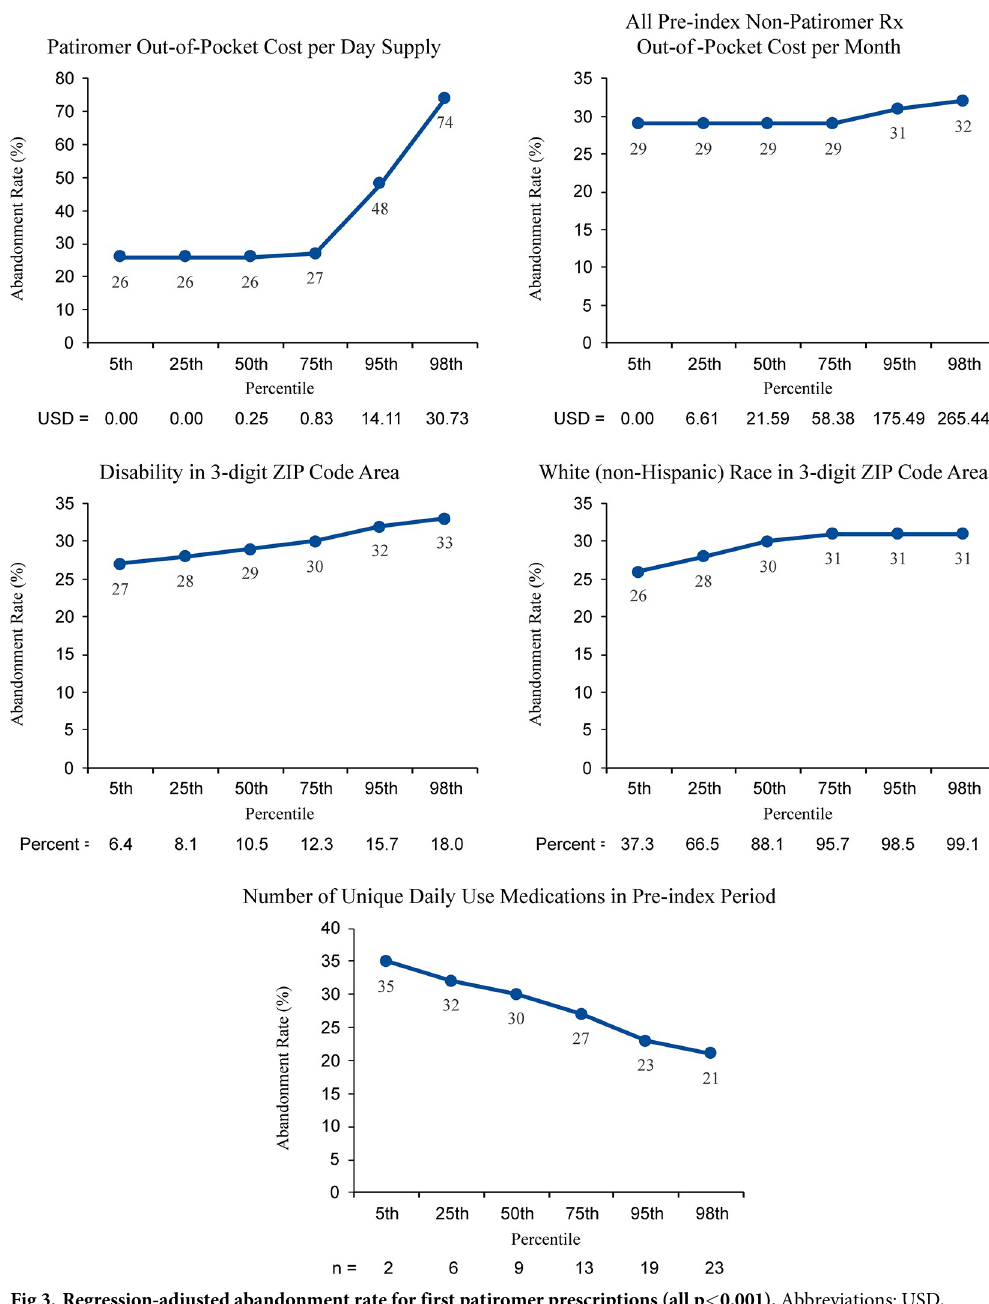
Fig 3. Regression-adjusted abandonment rate for first patiromer prescriptions (all p < 0.001). Abbreviations: USD, United States